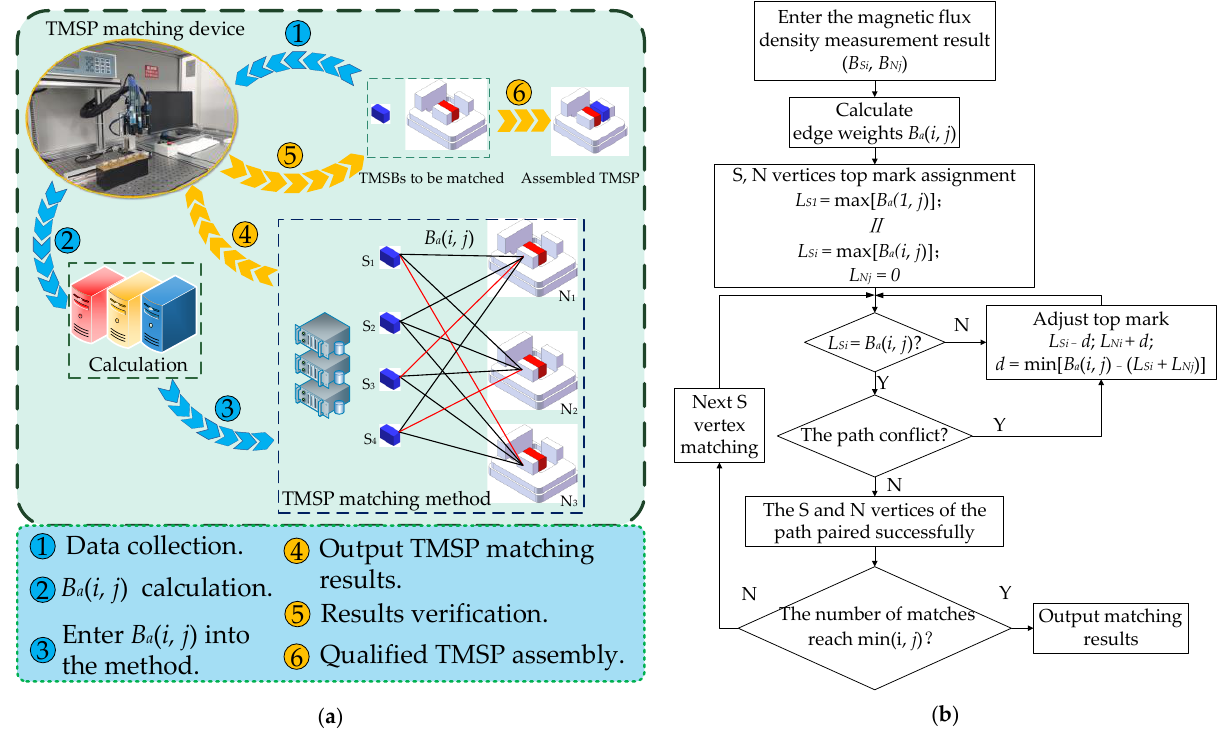
Figure 1. Tiny magnetic steel pair (TMSP) matching method. ( a ) Diagram; ( b ) Flow chart.